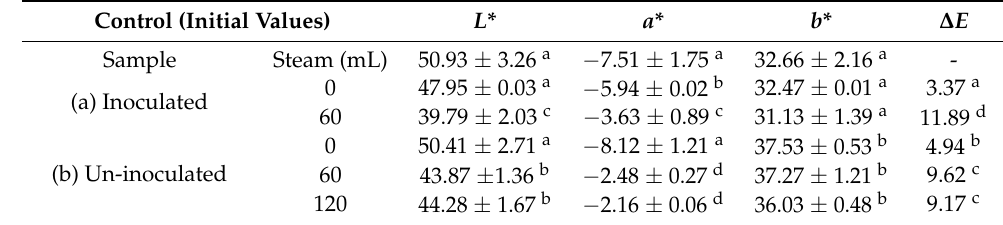
powder by vacuum-steam treatment (0, 60, and 120